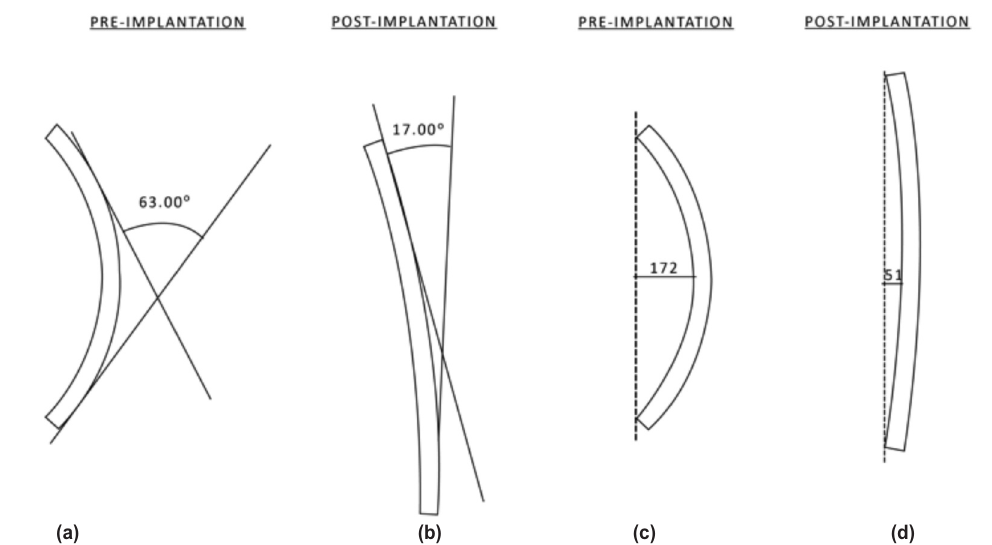
Example of outcome measures. (a) and (b) Show the angle of intersection of tangents to the rod end points. (c) and (d) Show Fig. 1: maximal deflection of the